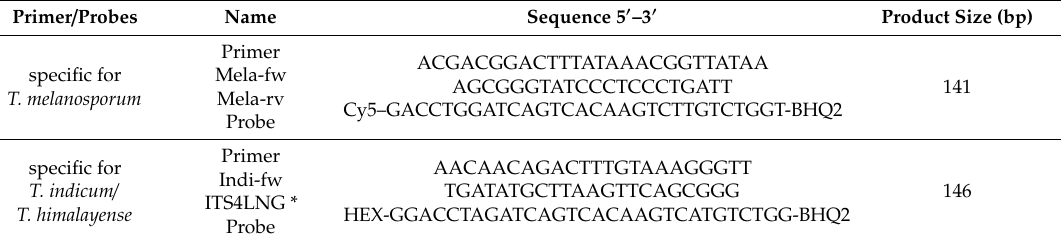
Table 2. Primer and probe sequences and size of PCR